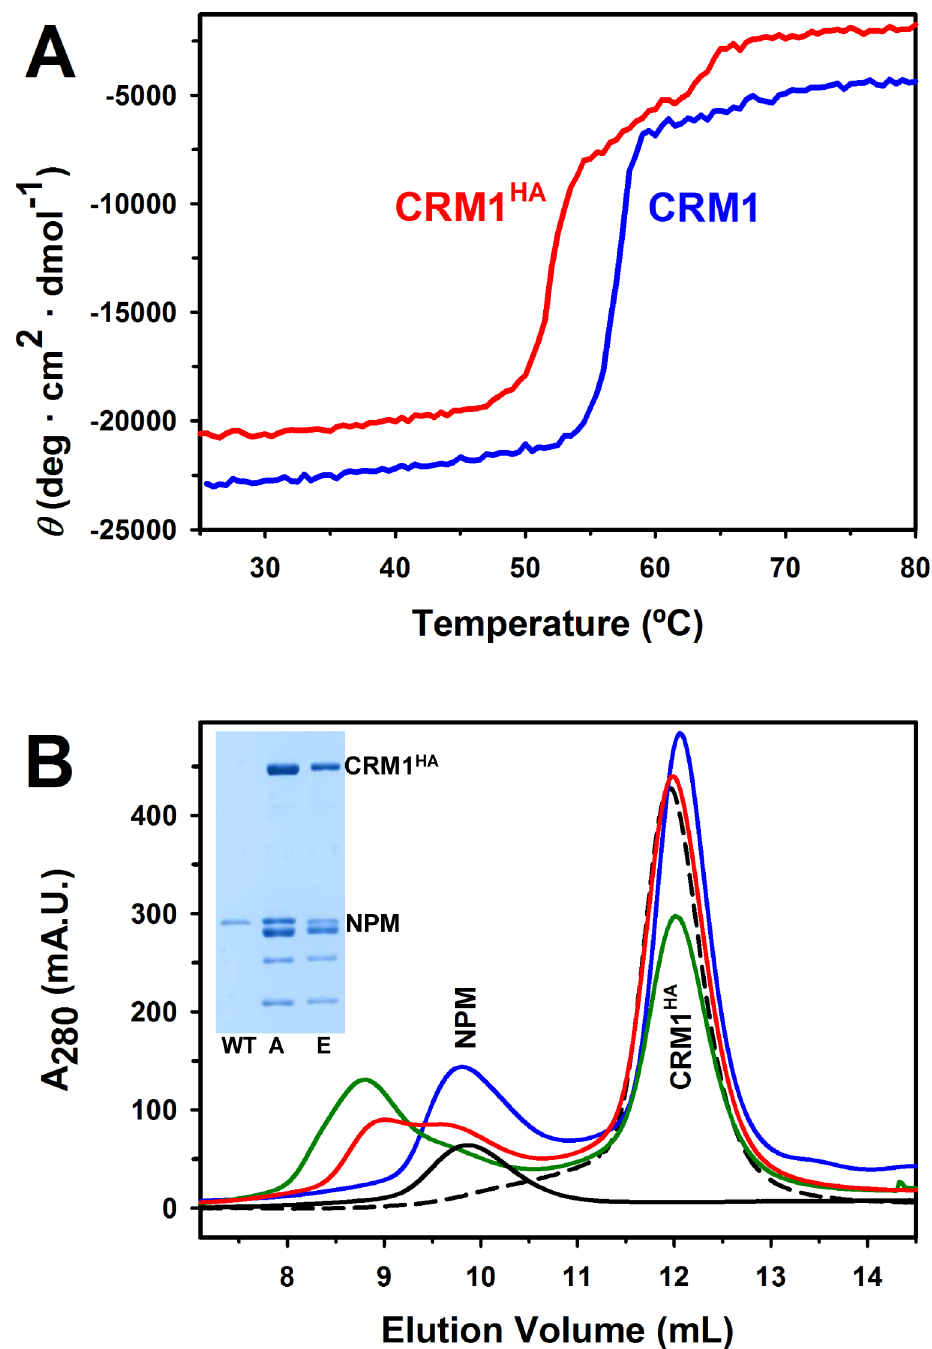
Fig 3. Native-like properties of CRM1 HA “ high affinity ” mutant [34] and formation of complexes between this CRM1 variant and AML-related NPM mutants. (A) Circular dichroism thermal denaturation profiles of wild type CRM1 and CRM1 HA , followed by ellipticity at 222 nm as a function of temperature. (B) Elution profiles of mixtures of 40 μ M CRM1 HA with 20 μ M (pentamer) of wild type NPM (blue), NPMmutA (green) and NPMmutE (red), as well as of the proteins alone (black) (the elution behavior of the three NPM variants is very similar, and only NPMmutE is shown for the sake of clarity). Samples were run in a Superdex 200 HR 10/30 column. When evaluating the relative amounts of the complex and free NPM, one should take into account that absorbance at 280 nm is lower for the mutants (especially NPMmutA) than for wild type NPM, since wild type NPM contains two Trp residues per subunit, NPMmutE one, and NPMmutA none.